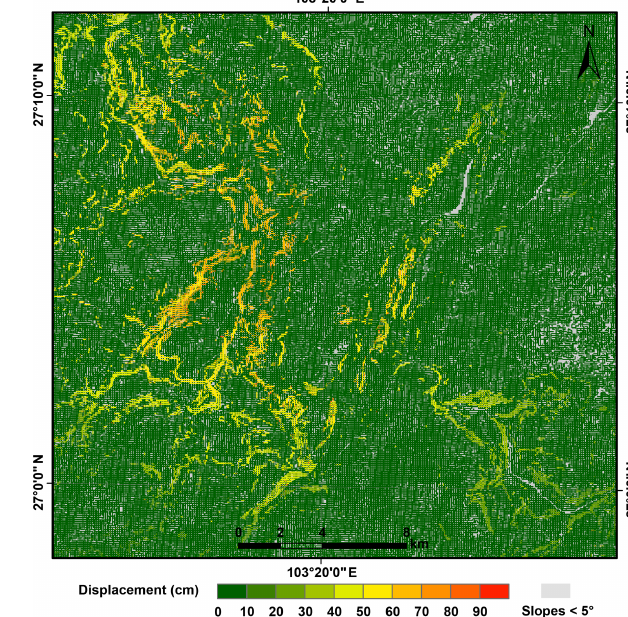
Figure 16. Map showing predicted displacements in the study